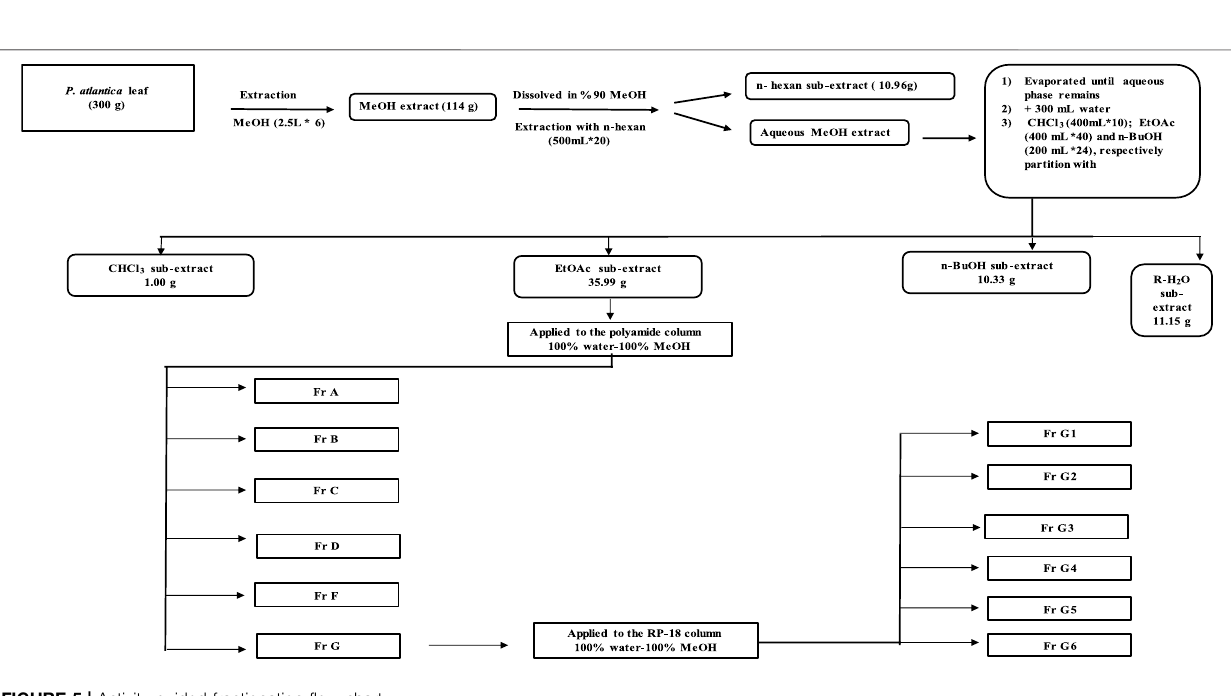
Frontiers in Pharmacology |